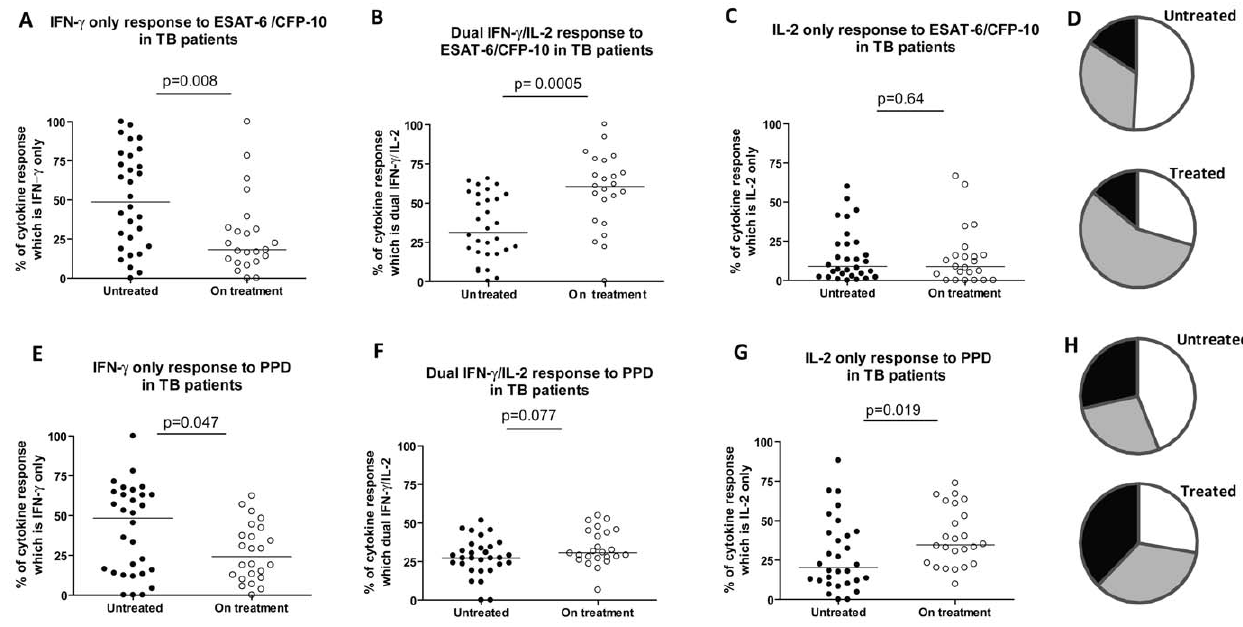
Figure 4. Cytokine responses to ESAT-6/CFP-10 and PPD in patients with Active TB before (n=32) and during treatment (after 3–9 months of treatment, n=24). PBMC from patients with active TB were stimulated with ESAT-6/CFP-10 (A-D) or PPD (E-H) and the number of IFN- c - only secreting cells (A,E) dual IFN- c /IL-2 –secreting cells (B,F) and IL-2-only secreting cells (C,G) were enumerated by fluorescence-immunospot. Data are expressed for all responding patients as the percentage of the total number of cytokine-secreting cells detected which were IFN- c -only, IL-2-only or dual IFN- c /IL-2 –secreting cells. Mean proportions of ESAT-6/CFP-10–specific and PPD-specific cytokine-secreting cells for each patient group are depicted as pie charts in figures D and H respectively (where white= IFN- c only, Grey = IFN- c /IL-2 and black = IL-2 only-secreting cells).